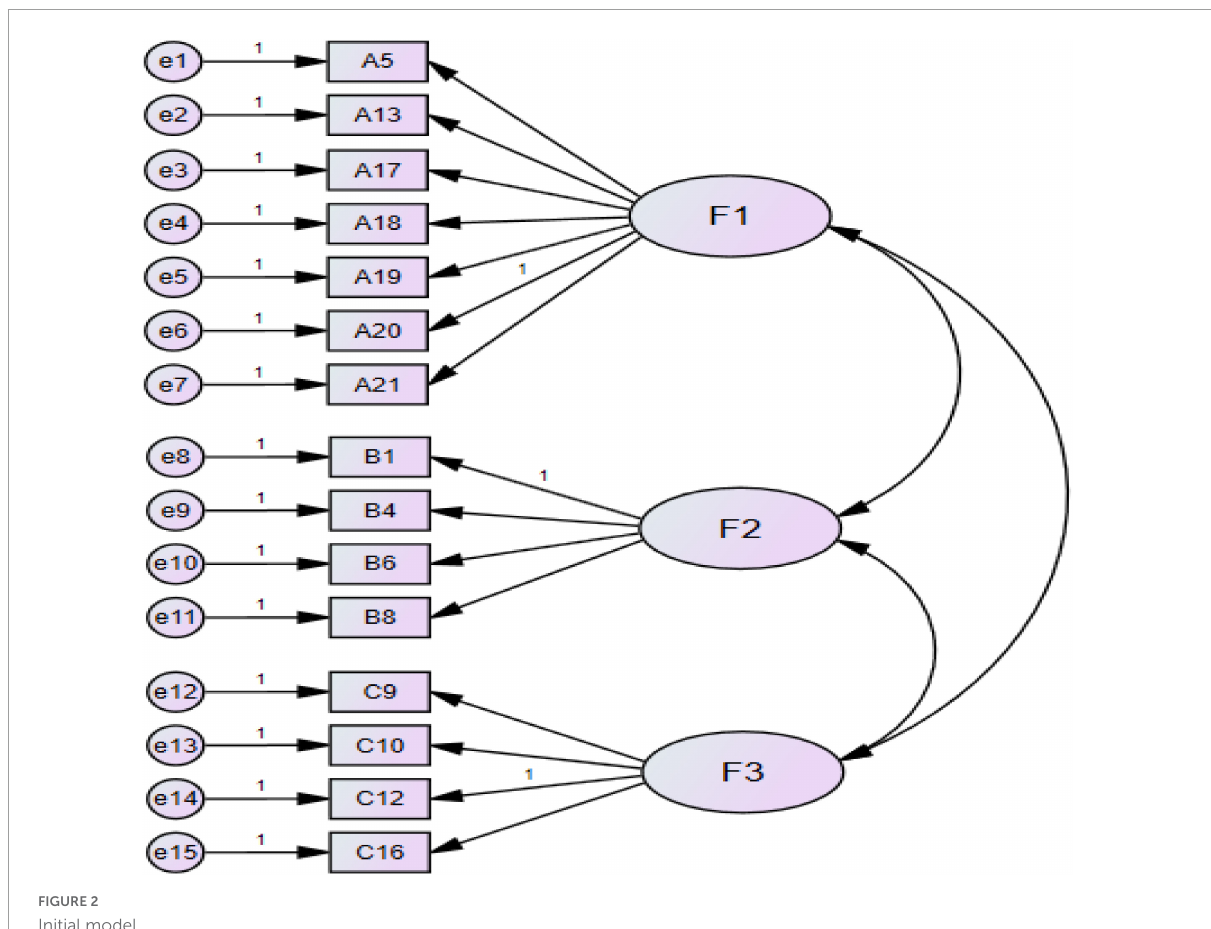
FIGURE2 Initial